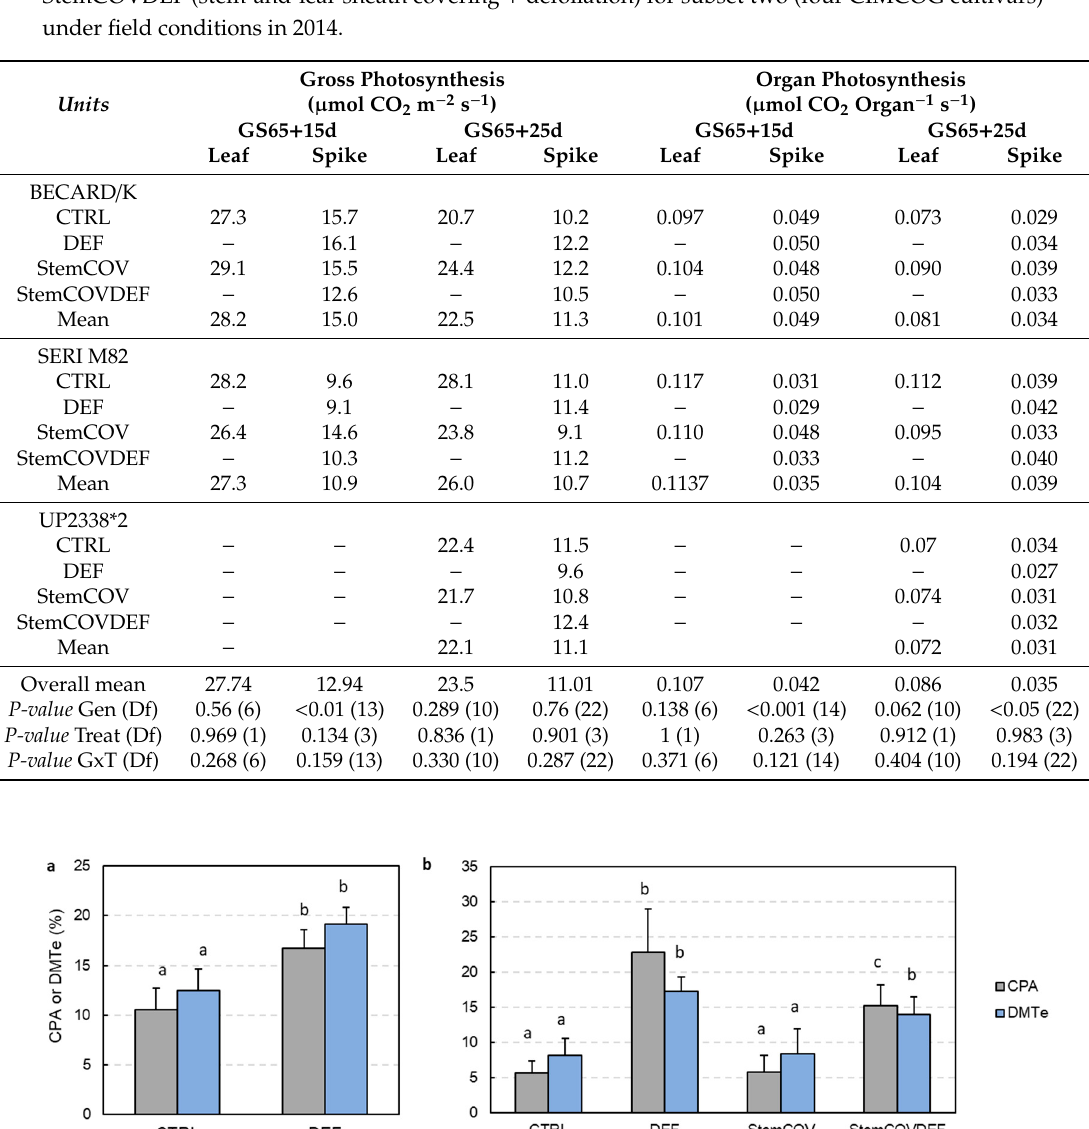
Table 4. Flag-leaf and spike photosynthetic rate per area (gross; µ mol CO 2 m − 2 s − 1 ) and per organ in CTRL (control), DEF (defoliation), StemCOV (stem-and-leaf-sheath covering treatment) and